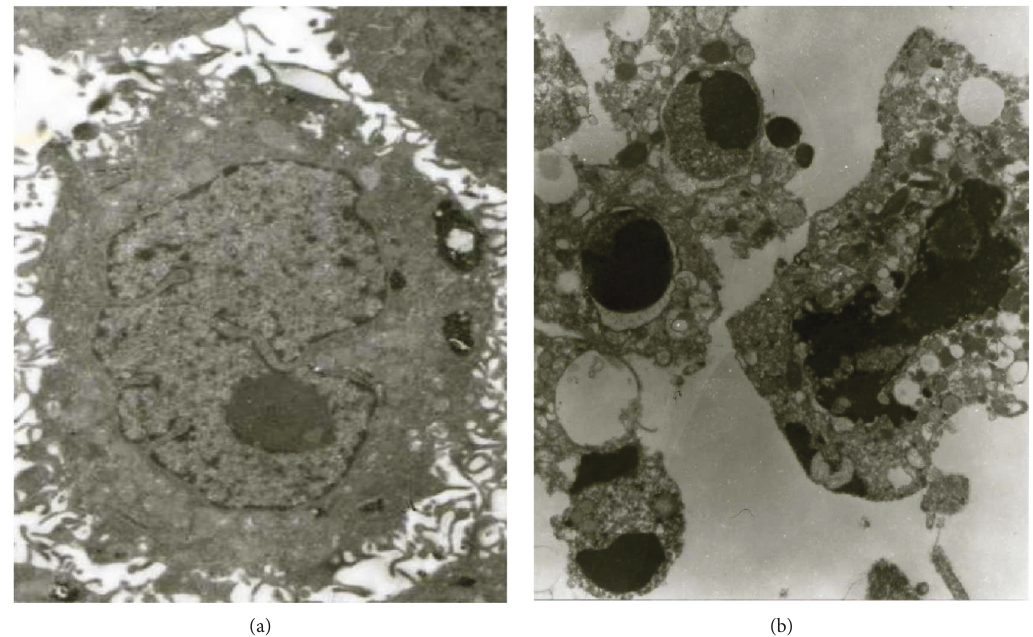
Figure 1: Ultrastructure of HepG2 cells (observed by TEM). (a) Cell without treatment ( × 15000). (b) Cell treated with radionuclide-gene- MFH for 48h. Chromatin condensation, apoptotic bodies, and cytoplasmic vacuolation were observed ( ×